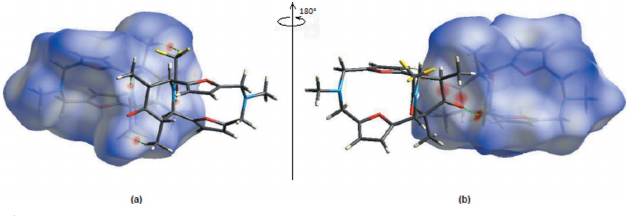
Figure 5 ( a ) Front and ( b ) back views of the three-dimensional Hirshfeld surfaces of the title molecule.